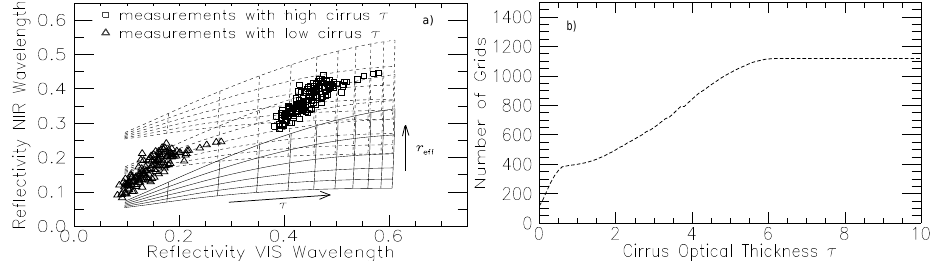
Fig. 18. (a) Illustration of systematic retrieval feature leading to an increasing underestimation of results for τ below 0.5. Displayed are three radiance grids following the approach of Nakajima and King (1990) for three different assumptions of the surface albedo at 650nm (0.05, 0.15, 0.25). Measurements for optically thick clouds are shown by squares. Triangles indicate measurements with low optical thickness. (b) Number of solution grids (lookup tables) based on homogeneous surface albedo distribution leading to a correct solution of the retrieval regulated by τ.